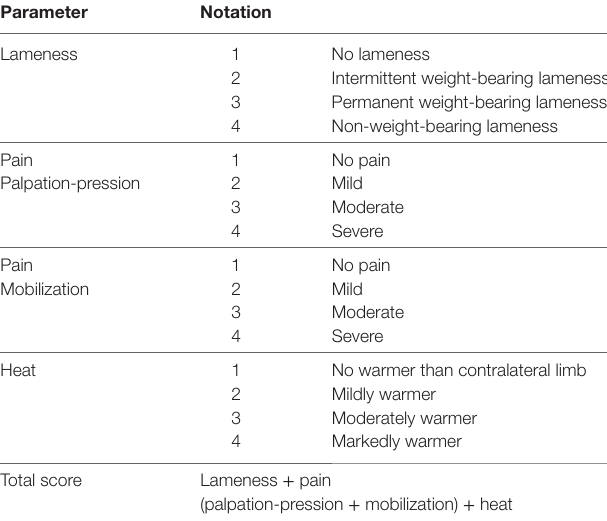
TaBlE 2 | Orthopedic pain scoring system. TaBlE 1 | French Veterinary Association for Anaesthesiology and Analgesia